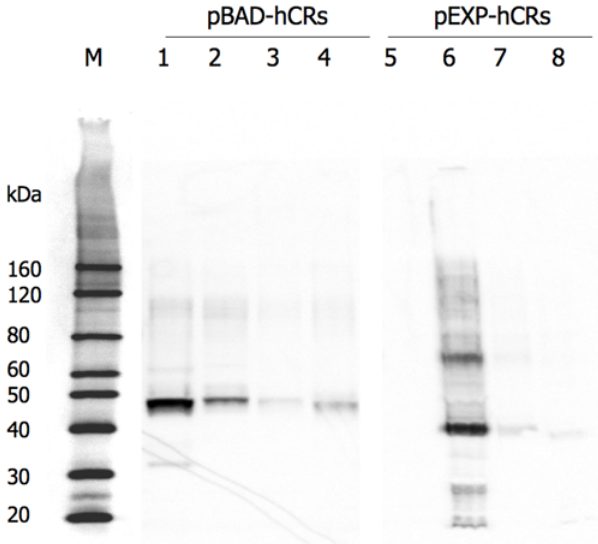
Figure 4. Expression of hCRs detected with Western blot using mouse anti-His 6 -tag monoclonal antibody. SDS-PAGE was per- formed using NuPAGE 4–12% Bis-Tris gel (Invitrogen, 1 6 MES buffer). Lane M, His-tagged protein standard size markers (Invitrogen); Lane 1 through 4, proteins expressed by pBAD-hCCR5, hCCR3, hCXCR4 and hCX3CR1 in Top10, respectively; Lanes 5 through 8, proteins expressed by pEXP-hCCR5, hCCR3, hCXCR4 and hCX3CR1 in C41, respectively. doi:10.1371/journal.pone.0004509.g004 (Figure 4). The plasmid stability correlated with their expression level, e.g. higher stability for pEXP-hCCR3 (80%) than for pEXP- hCXCR4 (66%), hCX3CR1 (62%) and hCCR5 (50%). Expression of pBAD-hCRs in Top10 was similarly studied as for pEXP-hCRs. All the genes were expressed after induction with 0.05% L-arabinose in TB medium at 16–18 u C from 2–24 hours.